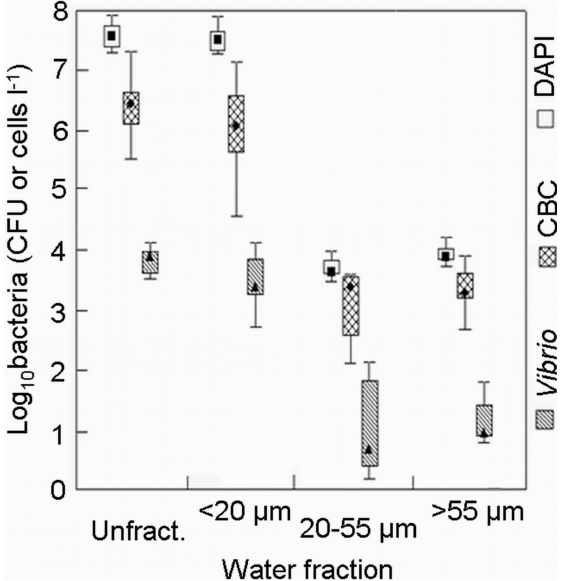
Fig. 3. Abundance of bacteria in surface water fractions ( < 20µm, 20–55µm, > 55µm, unfract.: unfractionated) displayed as box-and- whiskers plots (Statistica). Samples were collected from 9 locations in the eastern Atlantic Ocean. The bottom and top of the box plots indicate the 25th and 75th percentile. Closed symbols in the box indicate median values. The vertical bars show the standard devia- tions. DAPI and CBC represent culture independent total prokary- otes and cultivable bacterial counts, respectively. Vibrio represents counts on selective TCBS agar.